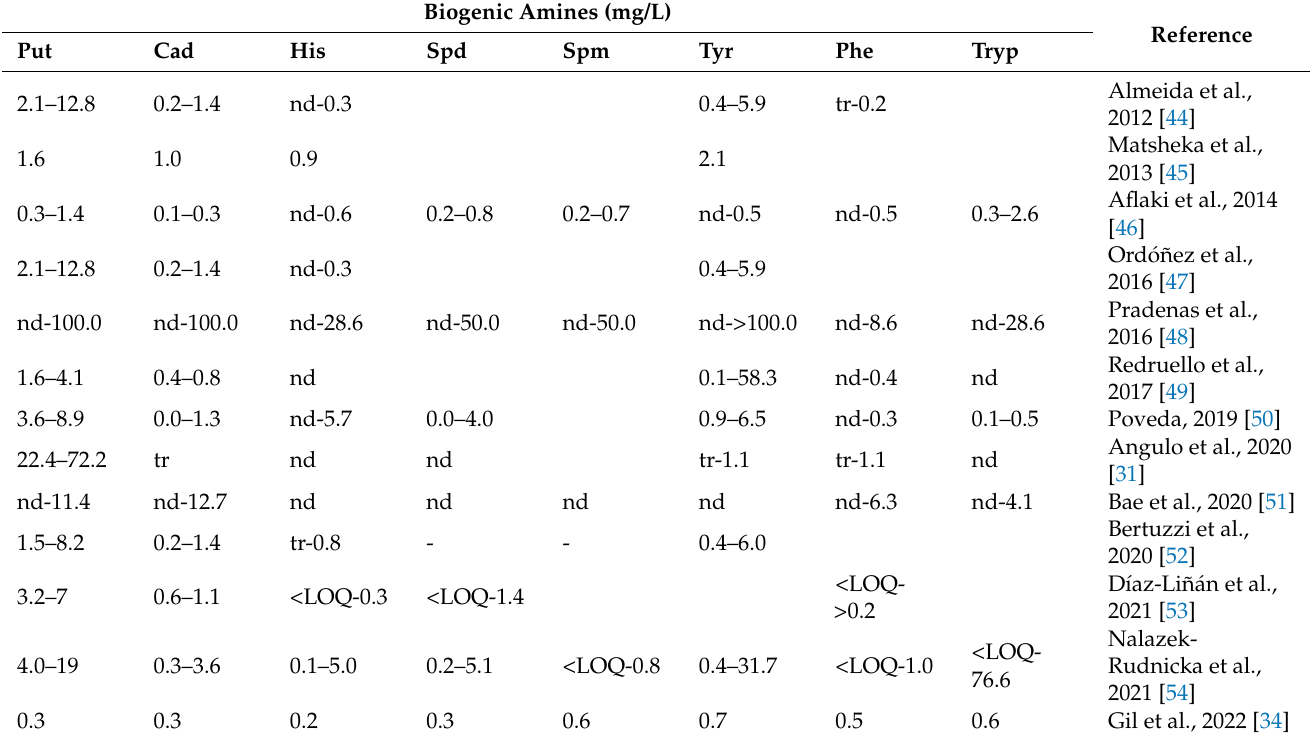
Table 3. Biogenic amines’ content (min–max values) in